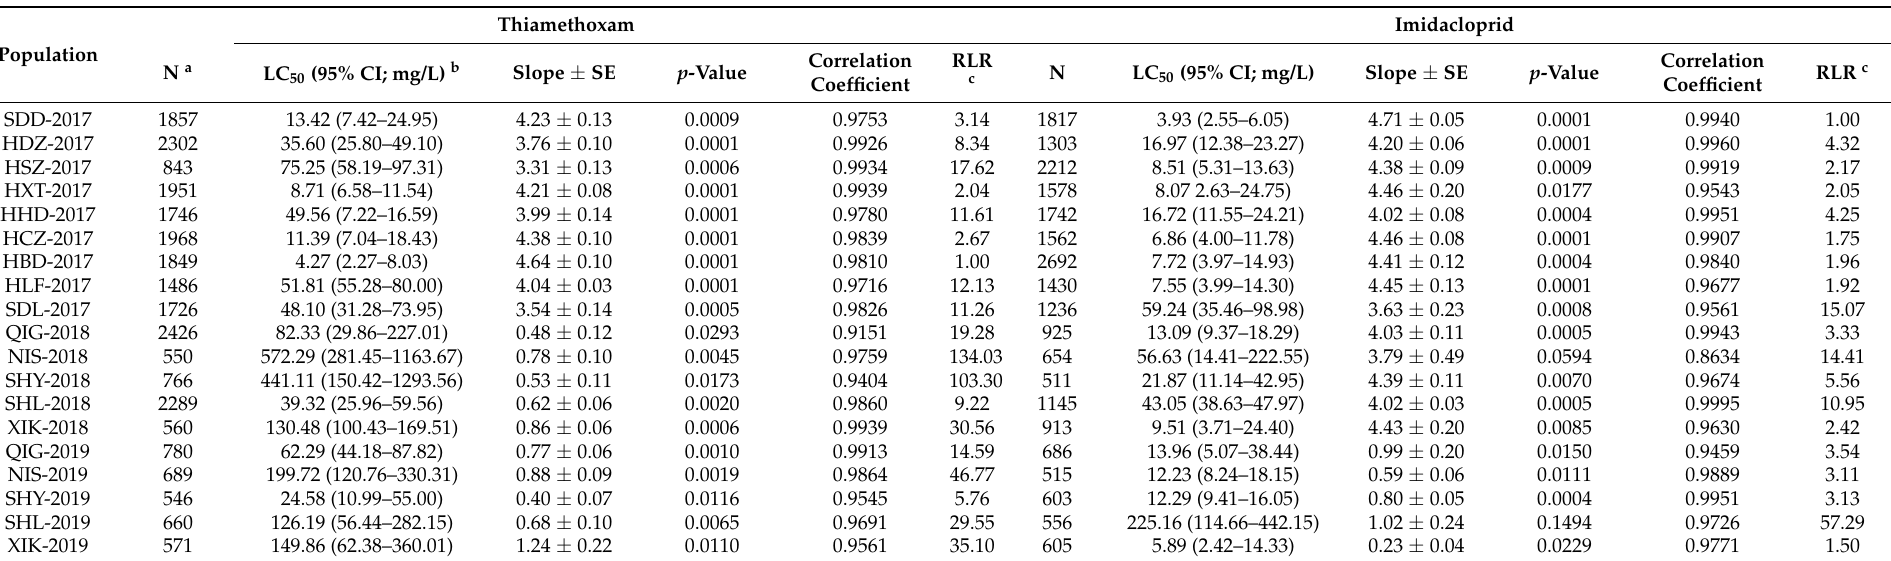
Table 3. Susceptibility of Metopolophium dirhodum field populations to imidacloprid and